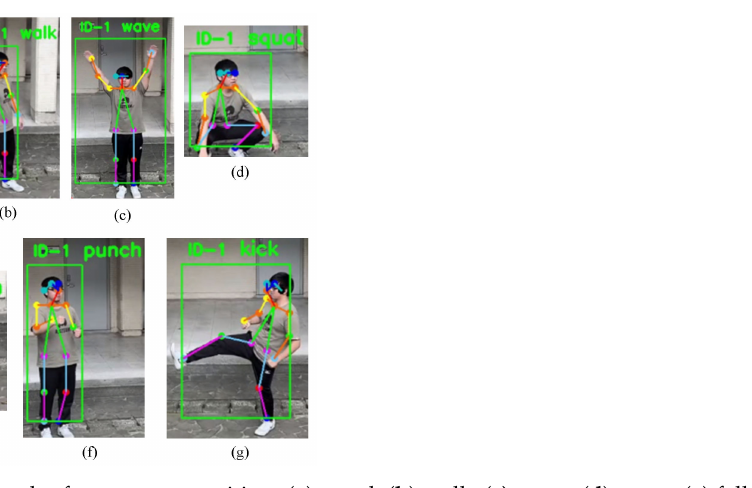
Figure 18. The result of posture recognition. ( a ) stand; ( b ) walk; ( c) wave; ( d ) squat; ( e ) fall down; ( f ) punch; and ( g ) kick.